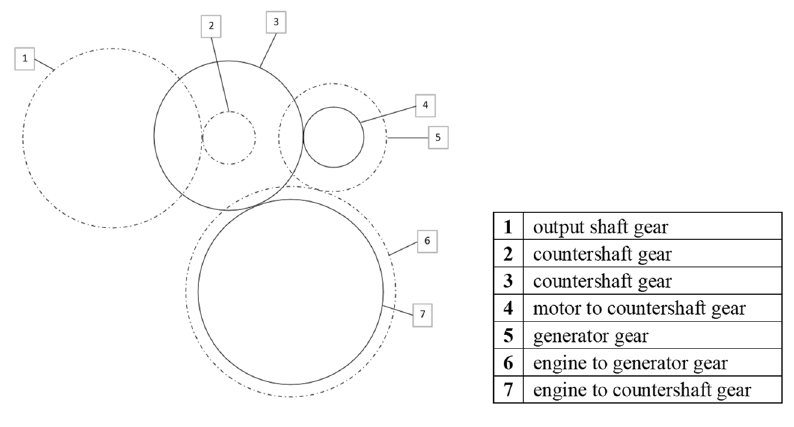
Figure 7. Transmission scheme of the HHS.